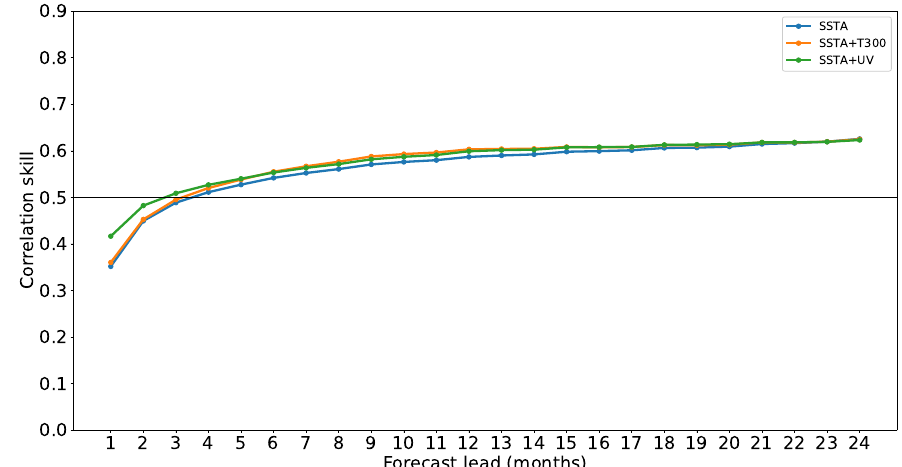
Figure 4. RMSE comparison of the models with different